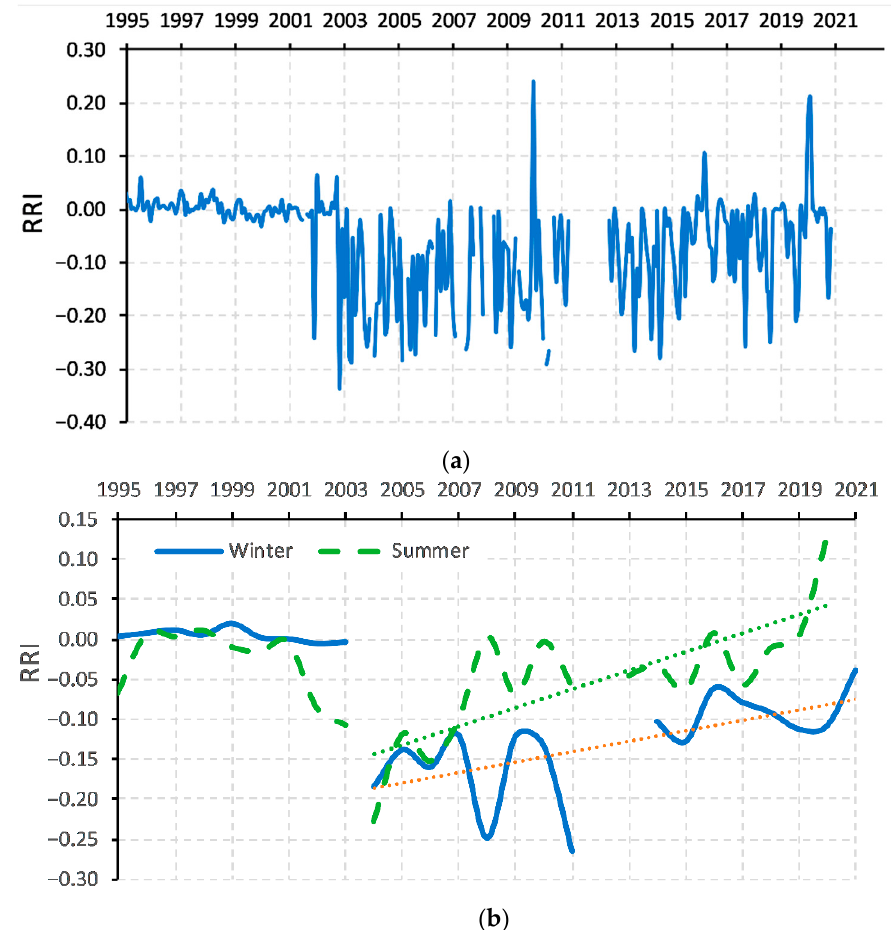
Figure 6. RRI dynamics: ( a ) 32-day-averaged time series; ( b ) the time series averages over the whole season (winter and summer) and the appropriate linear trends after the fire.